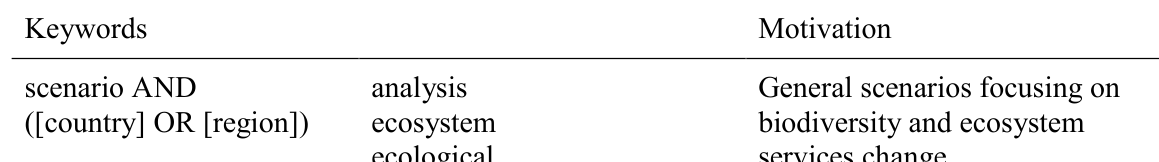
Table A2.1: Search terms used for the literature review.